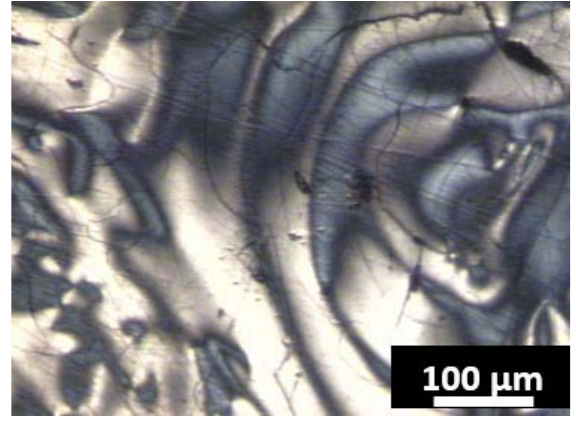
Figure 1. Polarized light micrograph of anthracene coke.